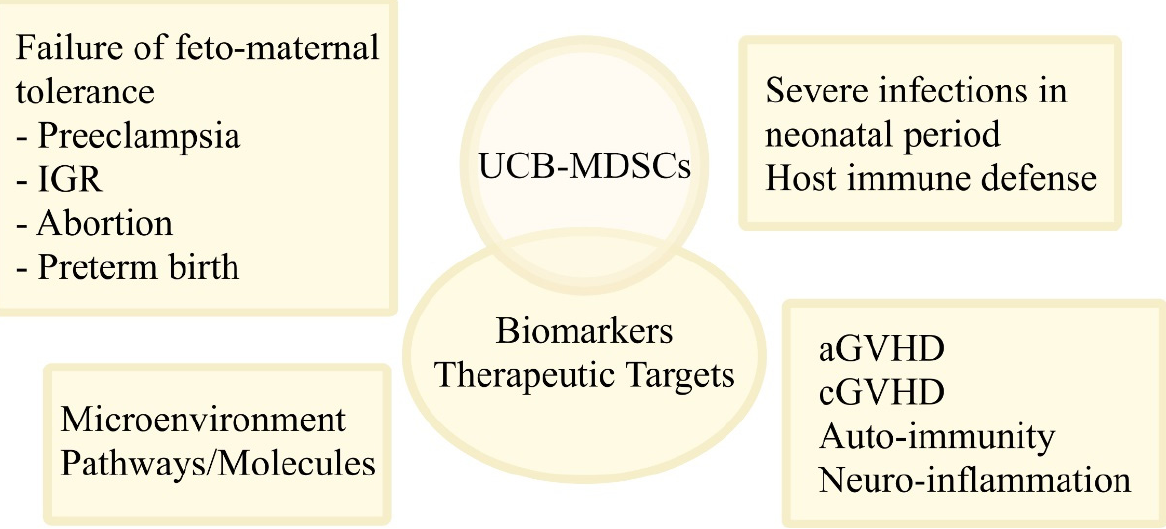
Figure 2. The role and potential applications of UCB-MDSCs. The use of UCB-MDSCs in clinical practice is currently under investigation. The MDSCs and molecules related to their function may be used as biomarkers or/and therapeutic targets in failure of feto-maternal tolerance (i.e., preeclampsia, IGR, abortion, preterm birth), in severe infections in neonatal period to facilitate the host immune defense in this period, in aGVHD and cGVHD, in auto-immunity, and in neuro-in- flammation. UCB-MDSCs are also involved in immune interactions within different microenviron- ments, including the umbilical cord, implicating cell-to-cell contacts and a variety of pathways and molecules. Abbreviations: UCB, umbilical cord blood; MDSCs, myeloid-derived suppressor cells; IGR, intra-uterine growth restriction; aGVHD, acute graft-versus-host disease; cGVHD, chronic GVHD.